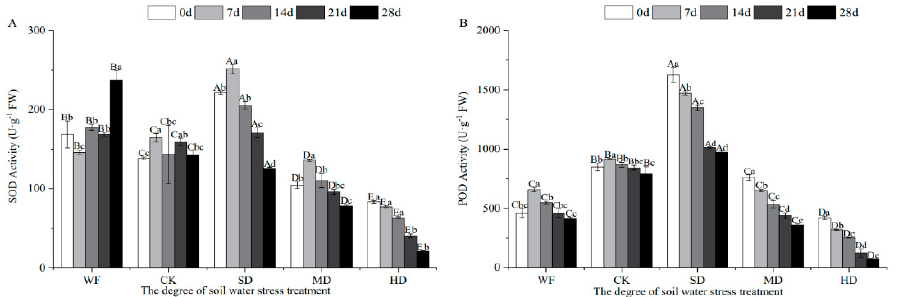
Figure 4. Effects of water stress on protective enzyme activities of C. retusus leaves. ( A ) Effects of water stress on SOD activities of C. retusus leaves. ( B ) Effects of water stress on POD activities of C. retusus leaves. Upper-case letters represent the variations in different treatment groups, and lower-case letters represent the difference in stress days within the group (significant). See the caption for Figure 1 for an explanation of abbreviations.